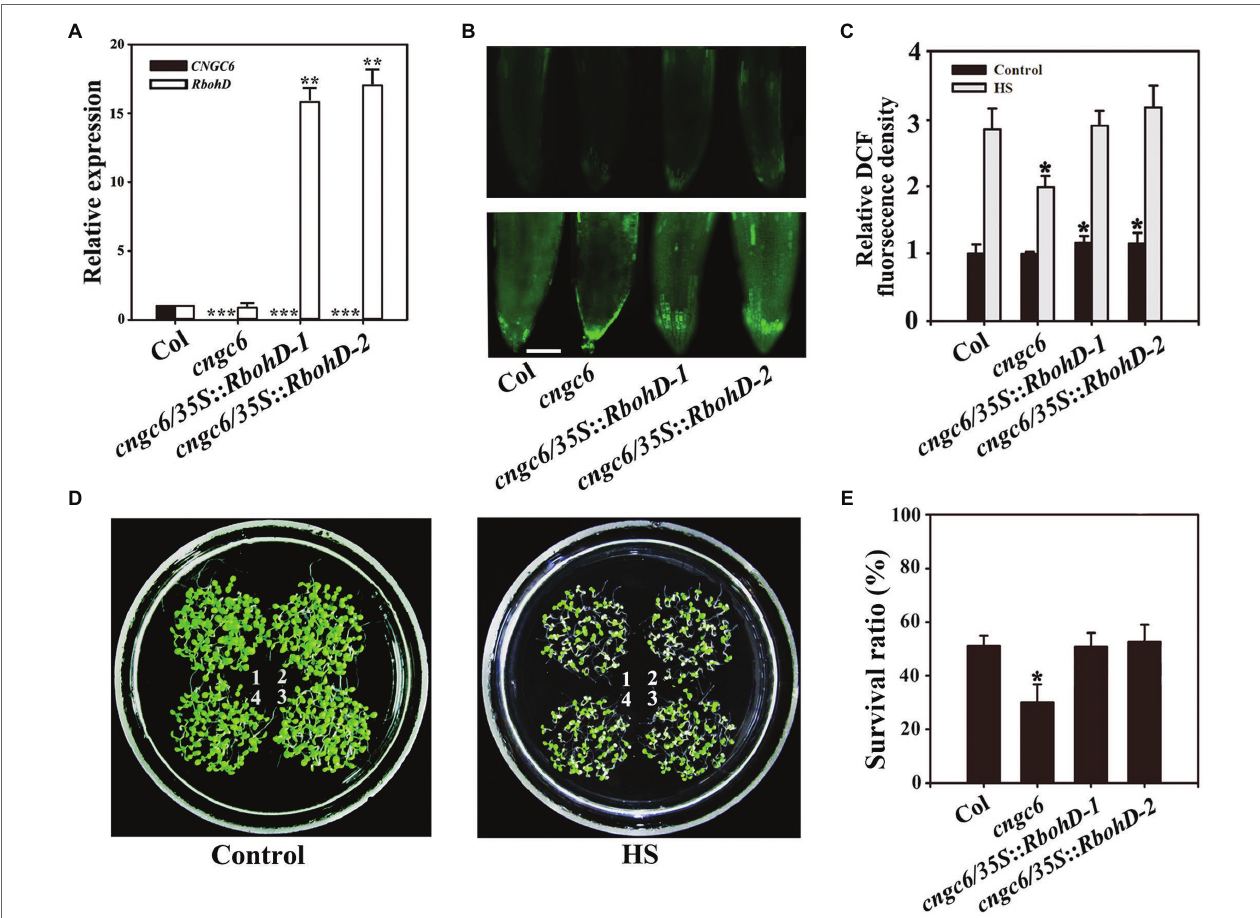
FIGURE 4 | Improved thermotolerance through AtRbohD overexpression in a cngc6 background. (A) RT-qPCR analysis of AtCNGC6 and AtRbohD transcription in wild-type, cngc6 , cngc6 / 35S :: RbohD-1 , and cngc6 / 35S :: RbohD-2 plants. The experiments were repeated three times with similar results. Each data point represents the mean ± SD ( n = 3). Asterisks indicate a significant difference relative to Col (Student’s t -test: ** p < 0.01 and *** p < 0.001). (B) About 8-day-old wild- type, cngc6 , cngc6 / 35S :: RbohD-1 , and cngc6 / 35S :: RbohD-2 seedlings grown at 22 ° C were exposed to 45 ° C (HS) or maintained at 22 ° C (Control) for 30 min. The H 2 O 2 levels in the plants were then examined by fluorescence microscopy using roots stained with CM-H 2 DCFDA. Bar = 100 μ m. (C) The relative DCF fluorescence densities in the roots. The data presented are the means ± SE of measurements taken from five independent experiments with at least 10 roots for each treatment. * p < 0.05 vs. Col. (D) Seedlings grown at 22 ° C were exposed to 45 ° C (HS) or maintained at 22 ° C (Control) for 100 min, then returned to 22 ° C and photographed 5 days later. The clusters are as follows: 1, wild-type; 2, cngc6 ; 3, cngc6 / 35S :: RbohD-1 ; and 4, cngc6 / 35S :: RbohD-2 . (E) Survival ratios of the seedlings after HS treatment. The data presented are the means ± SE of at least five independent experiments with 50 seedlings per experiment. * p < 0.05 vs. Col (Student’s t